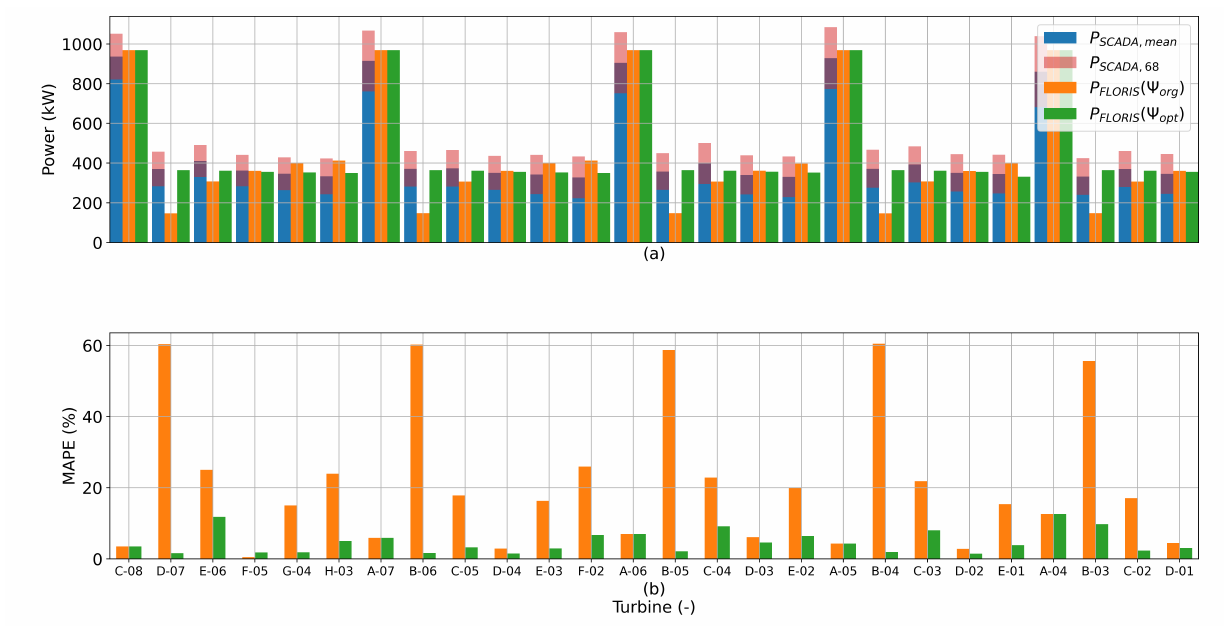
Figure 6. Bar plots for U ∞ = 8 m/s and θ ∞ = 180 ◦ of ( a ) P SCADA , P FLORIS ( Ψ org ) and P FLORIS ( Ψ opt ) and ( b ) the Mean Average Percentage Error